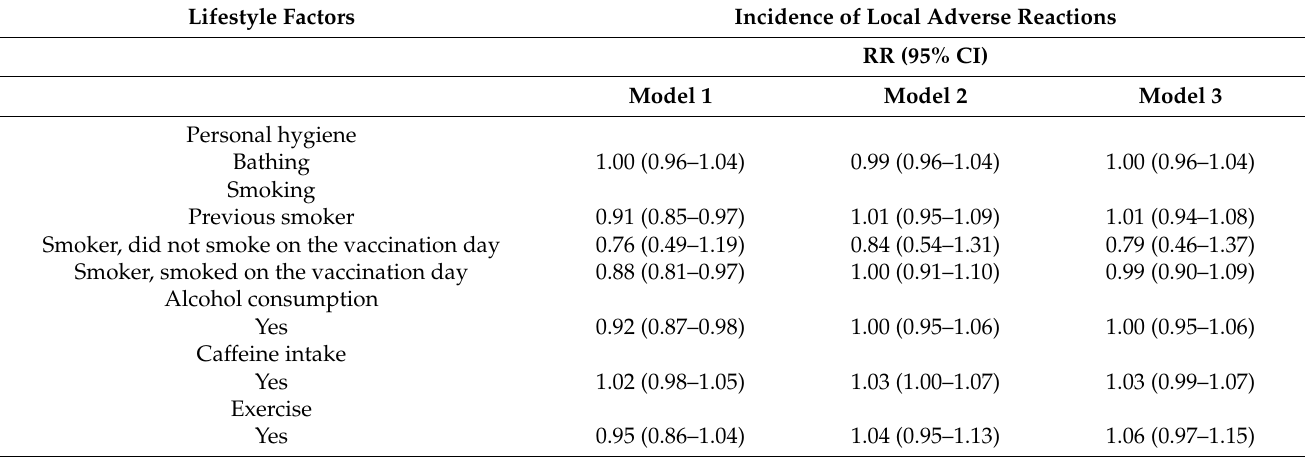
Table 4. Effect of lifestyle factors on local adverse reaction